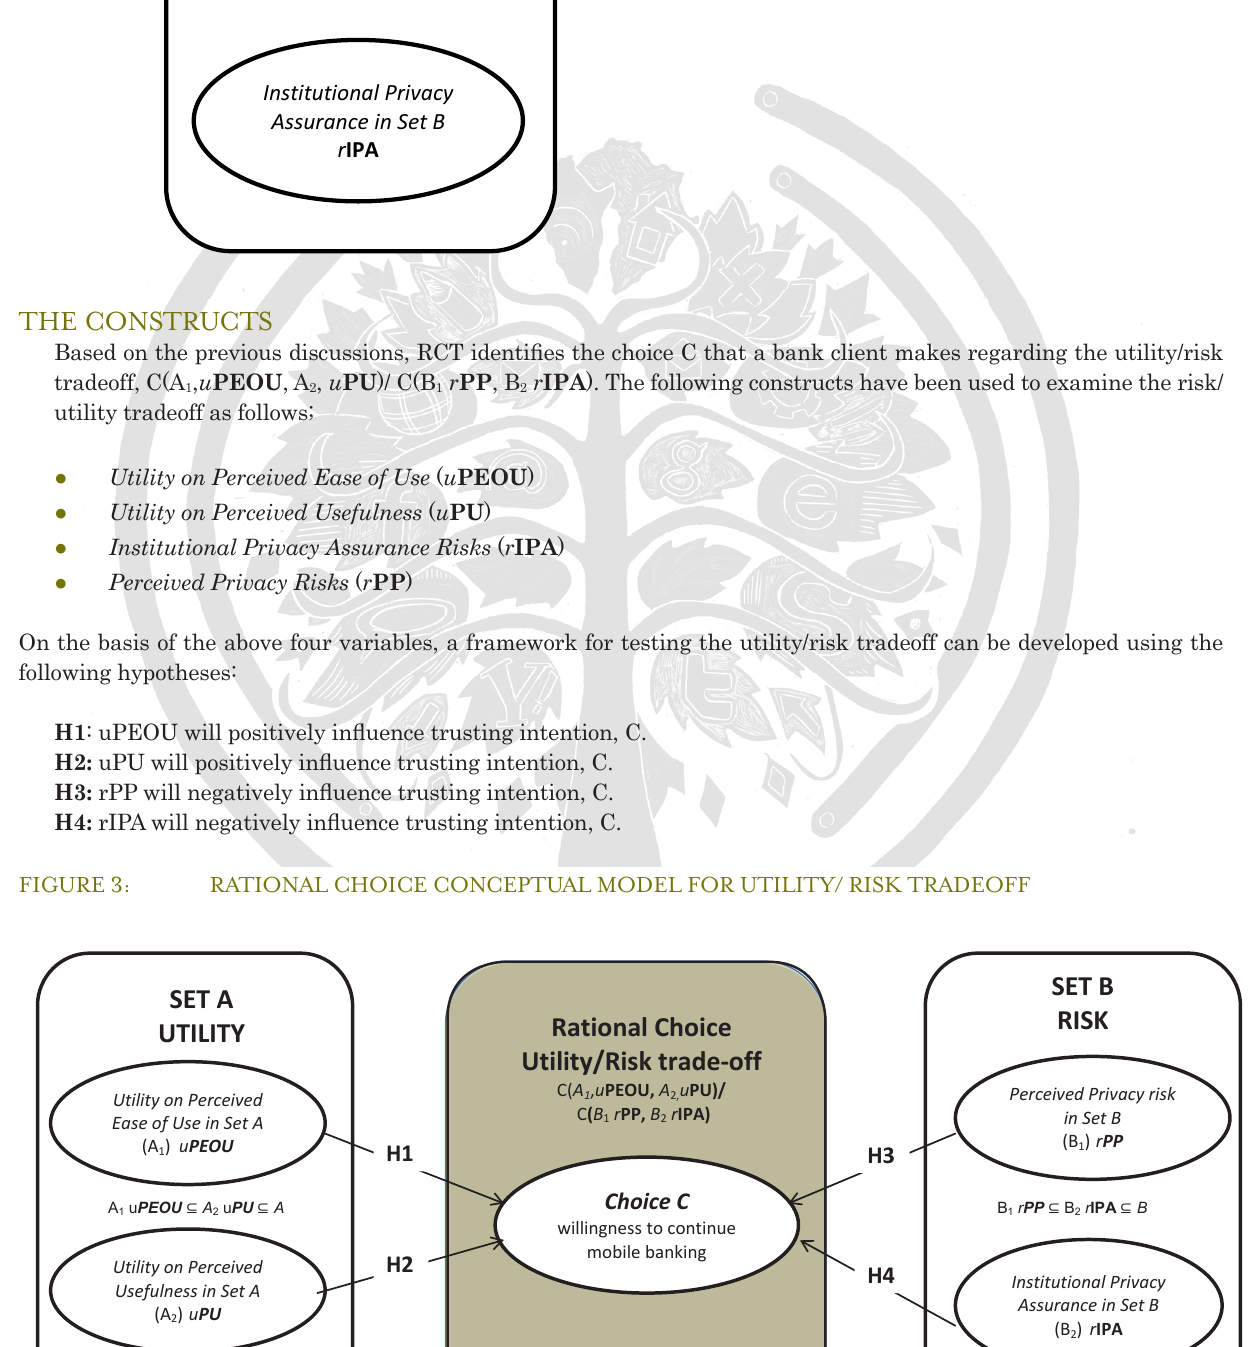
SET B RISK Perceived Privacy risk in Set B r PP